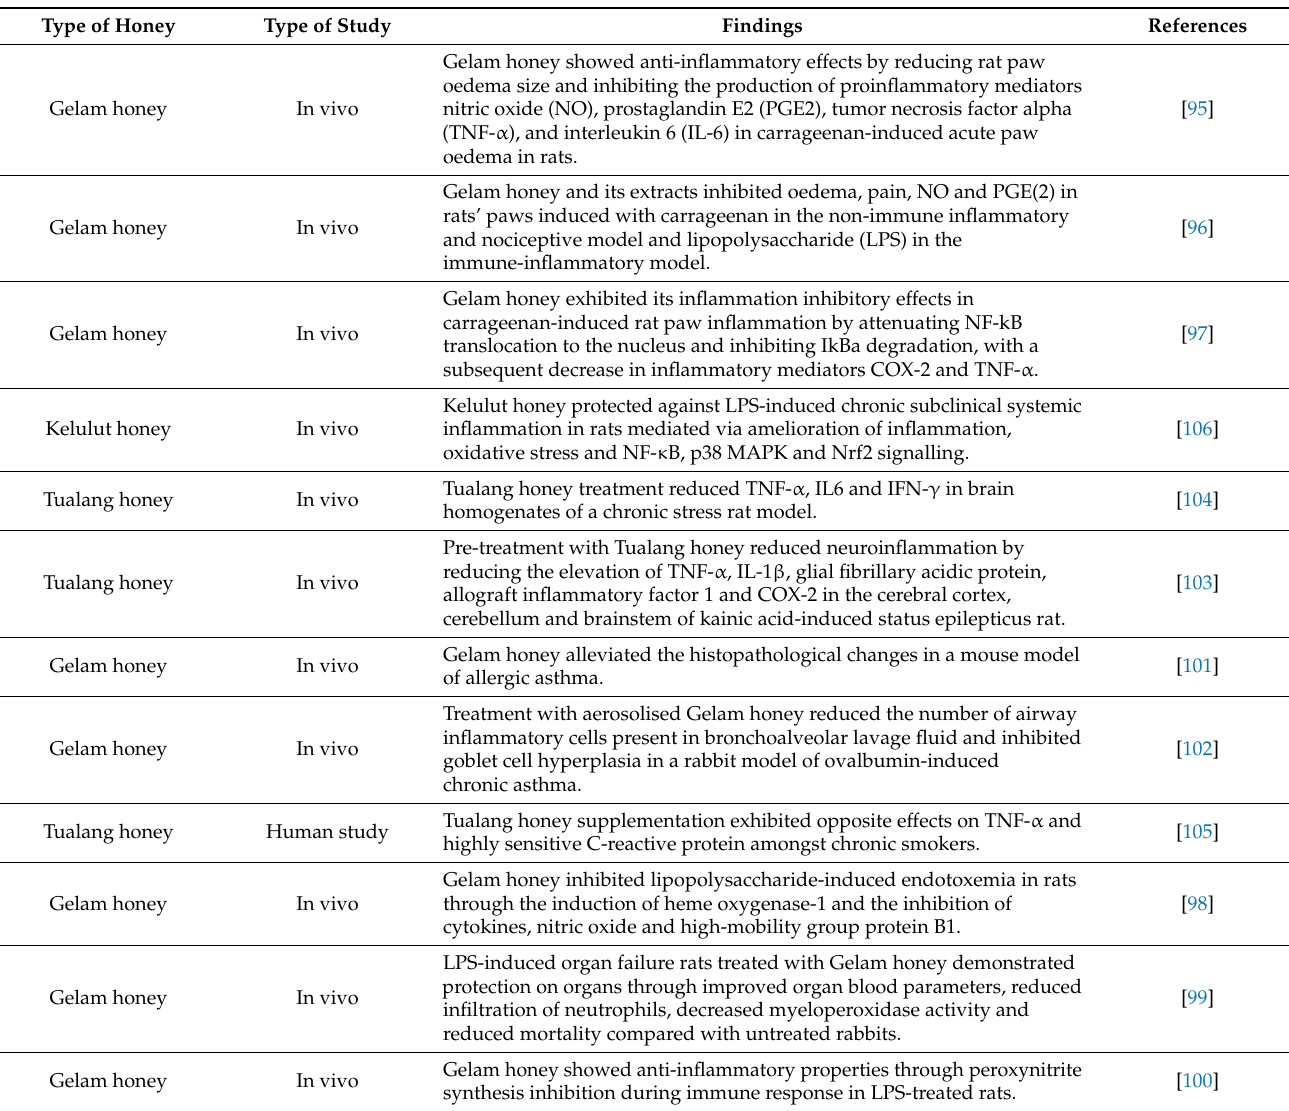
Table 6. Summary of anti-inflammatory